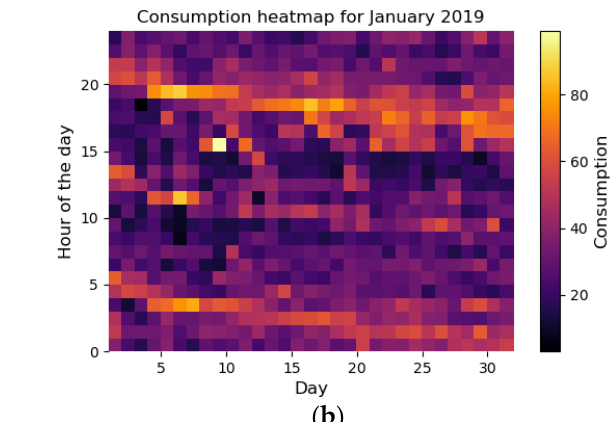
Figure 1. ( a ) A part of the electricity consumption raw dataset, ( b ) consumption heatmap for one month.